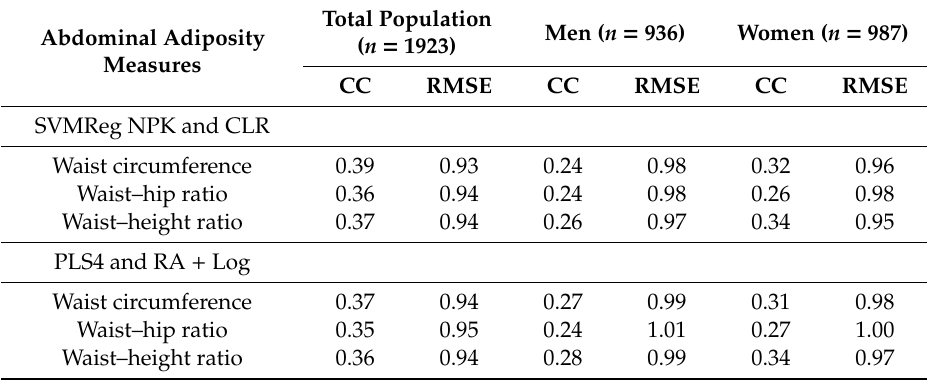
Table 3. Comparison of predictive performance in study population and sex-stratified subsets: Each (sub-)set was scaled (adiposity measure) and transformed (OTUs) separately. CLR: centered log-ratio; NPK: normalized poly kernel; RA: relative abundance (100%); PLS4: partial least squares with four principal components; SVMReg: support vector machine